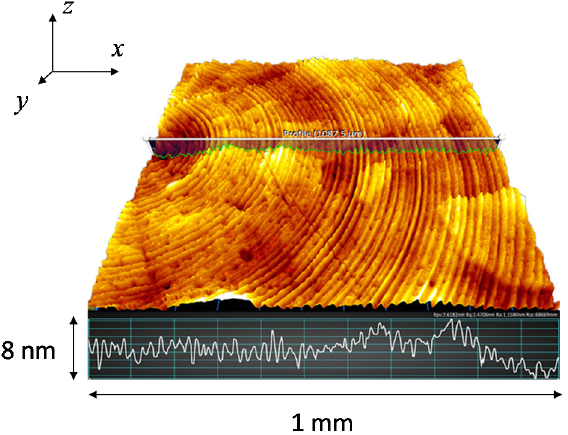
Figure 1. An example of optical surface topography measurement requiring nm-level sensitivity to surface heights.